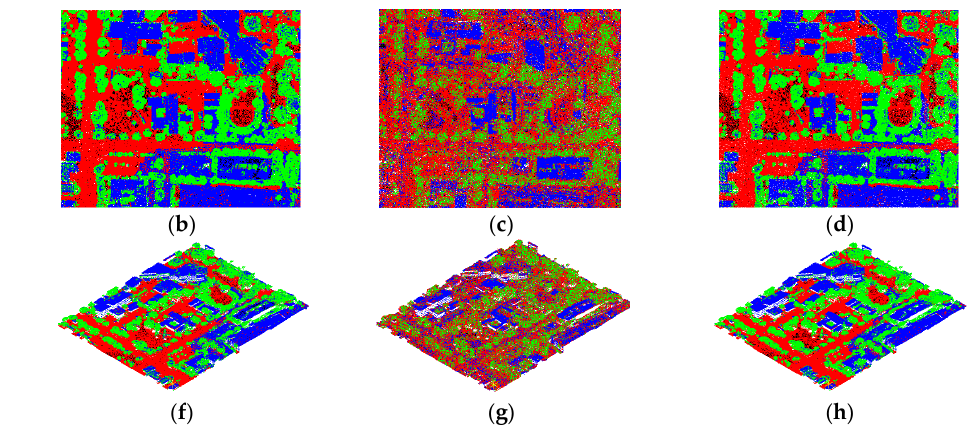
Figure 3. Point cloud classification results from different data sources: ( a ) original data in top view; ( b ) result from optical image in top view; ( c ) result from LiDAR in top view; ( d ) result from data fusion in top view; ( e ) original data in side view; ( f ) result from optical image in side view; ( g ) result from LiDAR in side view; ( h ) result from data fusion in side view.